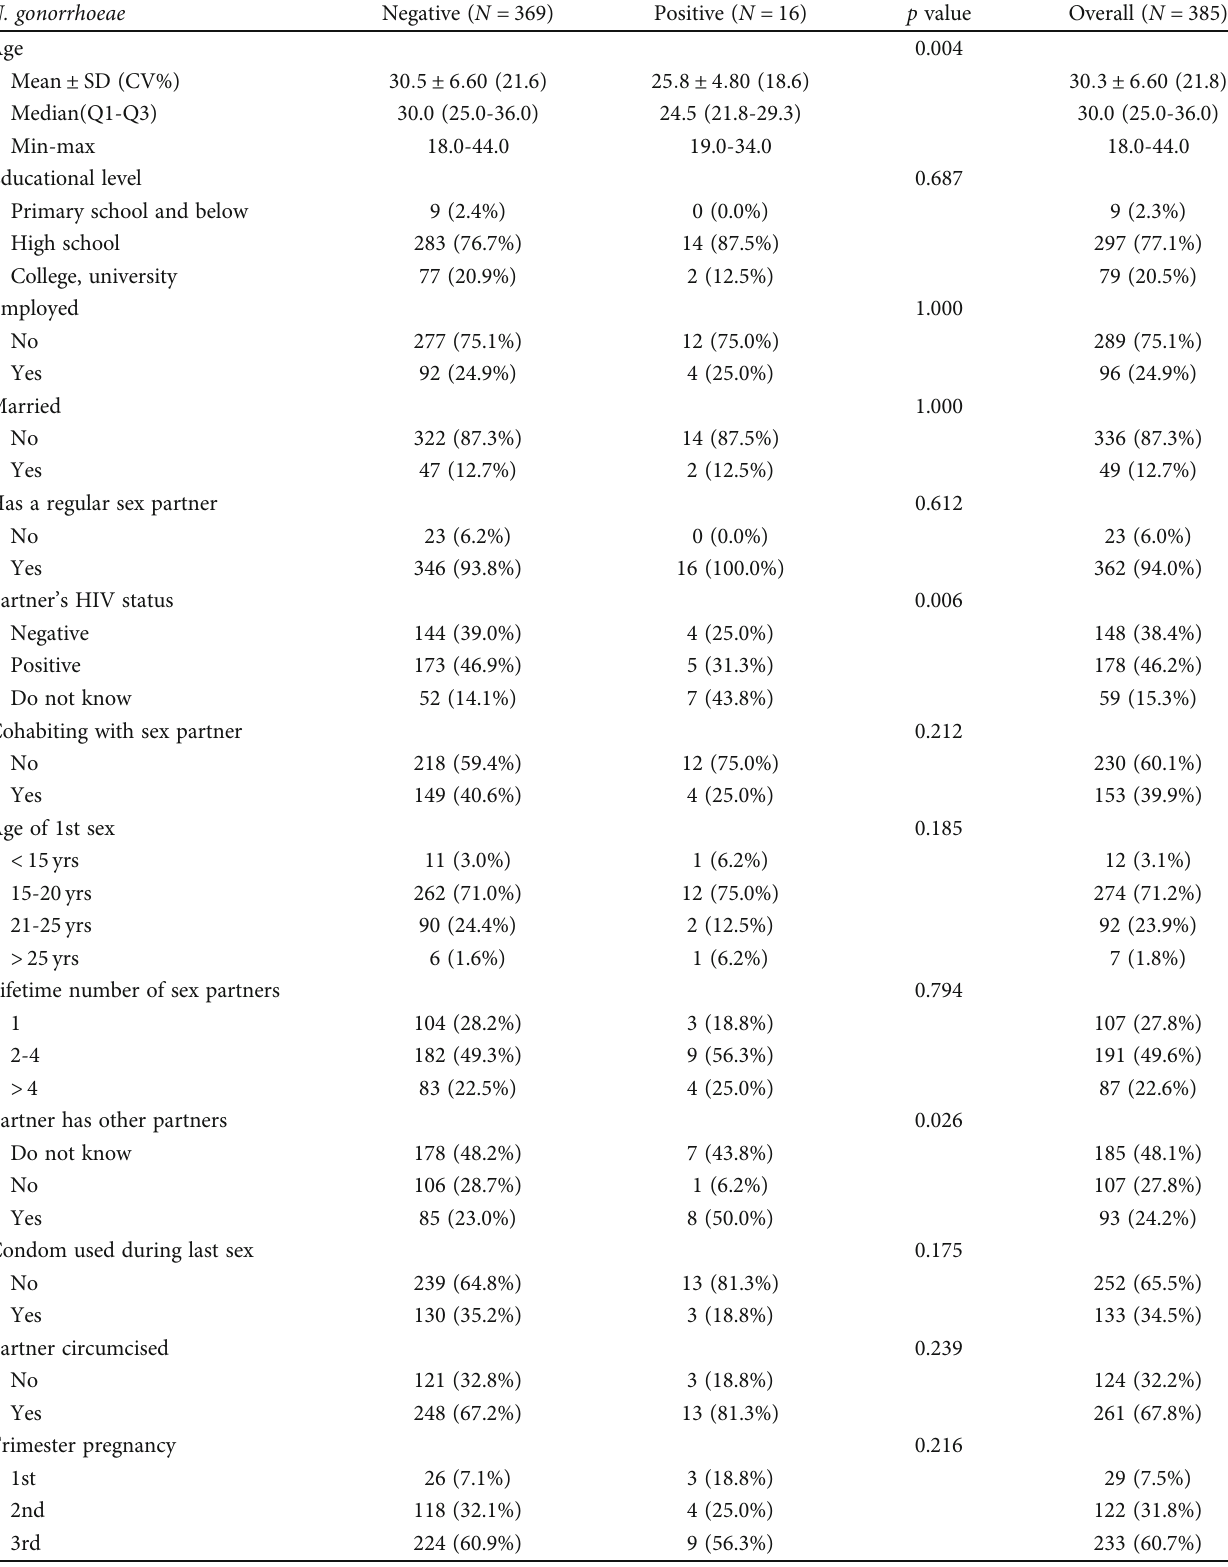
Table 2: Characteristics of the study population based on N. gonorrhoeae